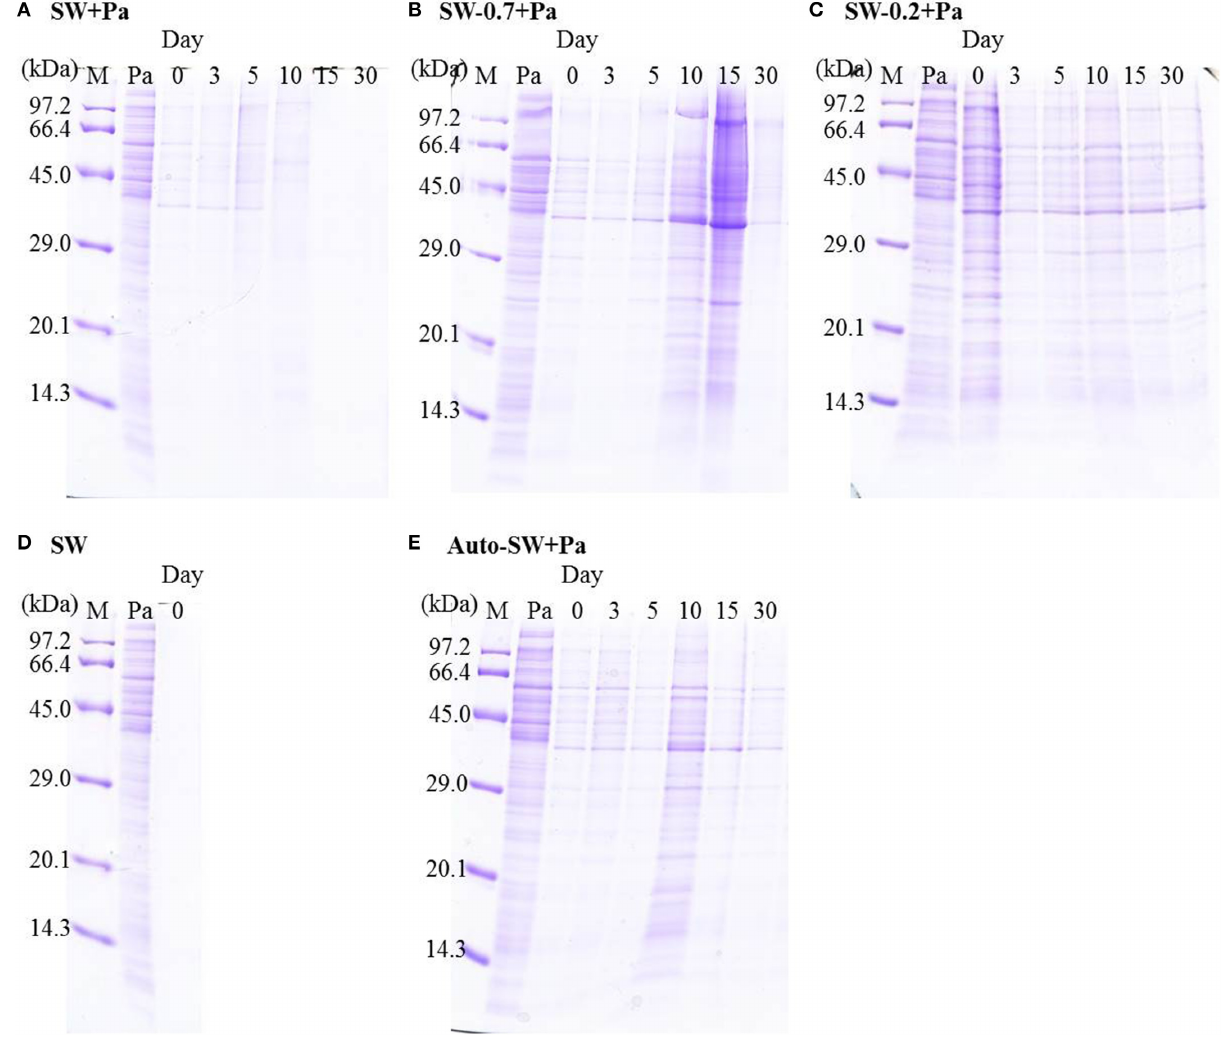
FIGURE 4 | SDS-PAGE profiles of proteins in the (A) SW + Pa, (B) SW-0.7 + Pa, (C) SW-0.2 + Pa, (D)SW, and (E) Auto-SW + Pa microcosms. M, molecular size marker; Pa, proteins from P. aeruginosa